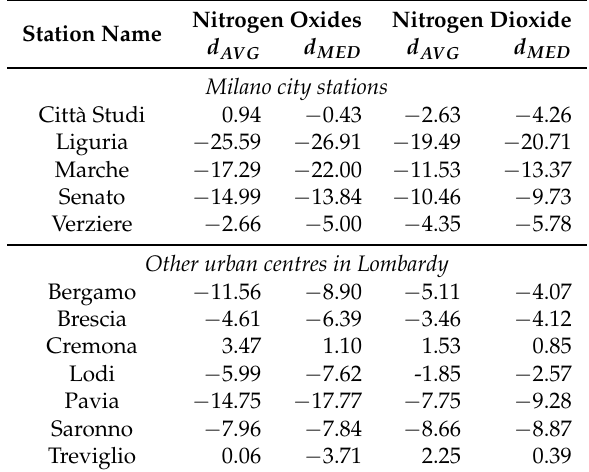
Table 1. Differences between the average concentration level of the sub-period 2014–2018 and the treatment period 2019. Differences are expressed in µ g/m 3